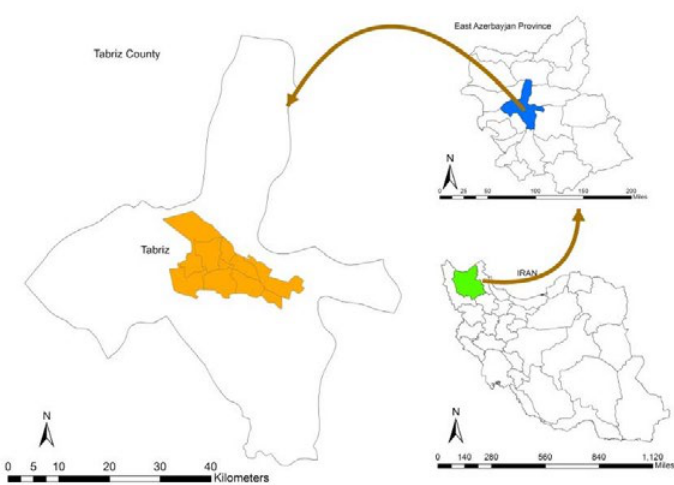
Fig. 1: Location of the study Fig 1: Location of the study area